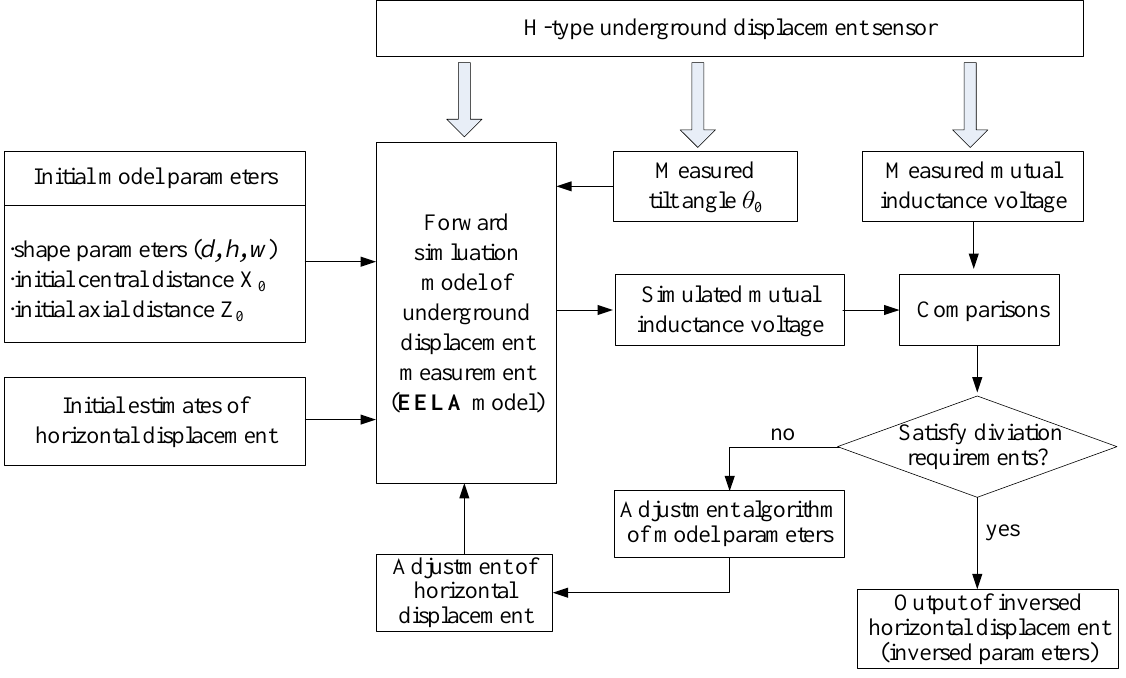
Figure 3. Schematic diagram of displacement parameter inversion for the H-type